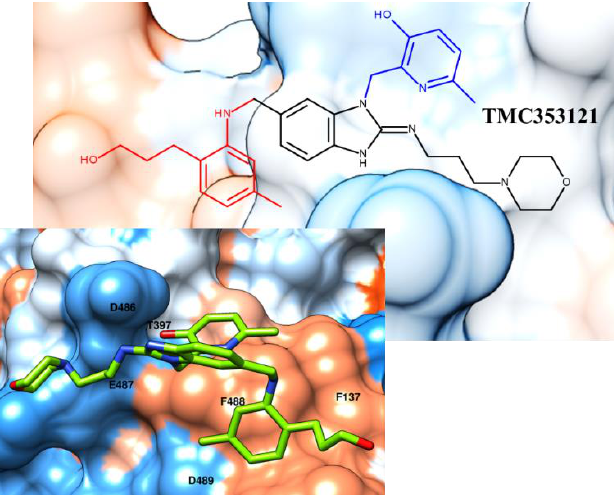
Figure 5. Chemical structure and X-ray positioning of TMC353121 (pdb code: 5EA5) [31] in complex with the RSV F protein. The chemical motif of the inhibitor maintained the key contacts displayed by the analogues BMS-433771 and JNJ-53718678; they are highlighted in blue and red. Hydrophobic and polar areas of the protein are represented as blue and orange regions on the RSV F protein’s Connolly surface.